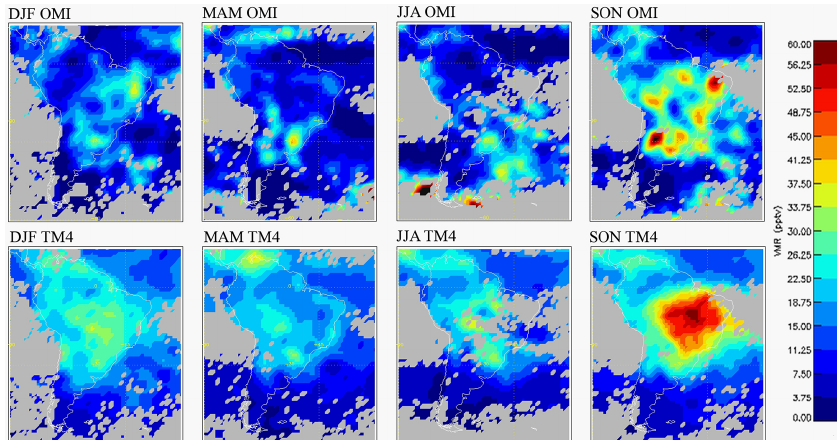
Figure 20. Same as Fig. 19 but at 380hPa.